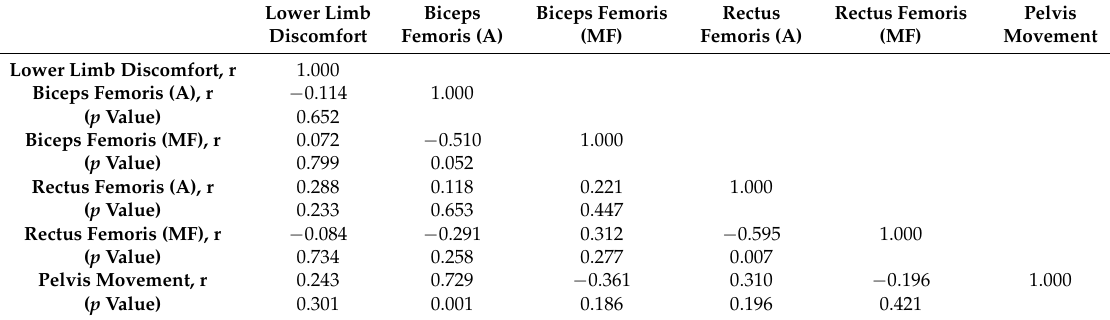
Table 5. Change score correlations (r) between lower limb discomfort, muscle fatigue [amplitude (A) and median frequency (MF)] and pelvis movement over 2 h prolonged sitting.